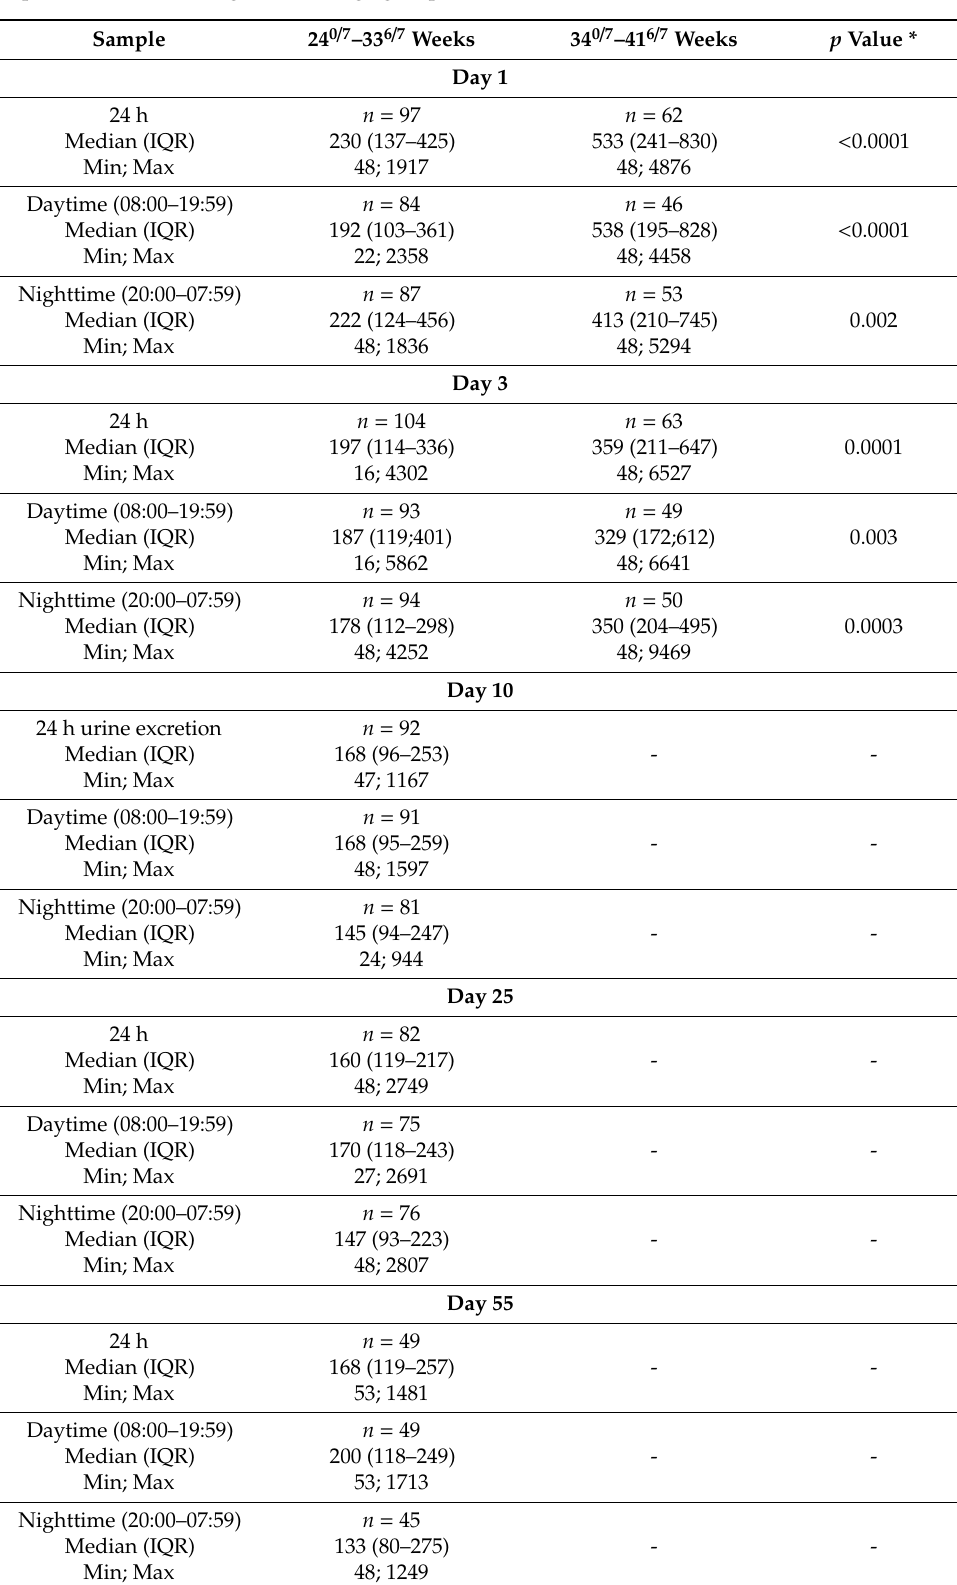
Table 2. Urine 6-sulfatoxymelatonin concentrations (in ng / L) in newborns on Days 1, 3, 10, 25 and